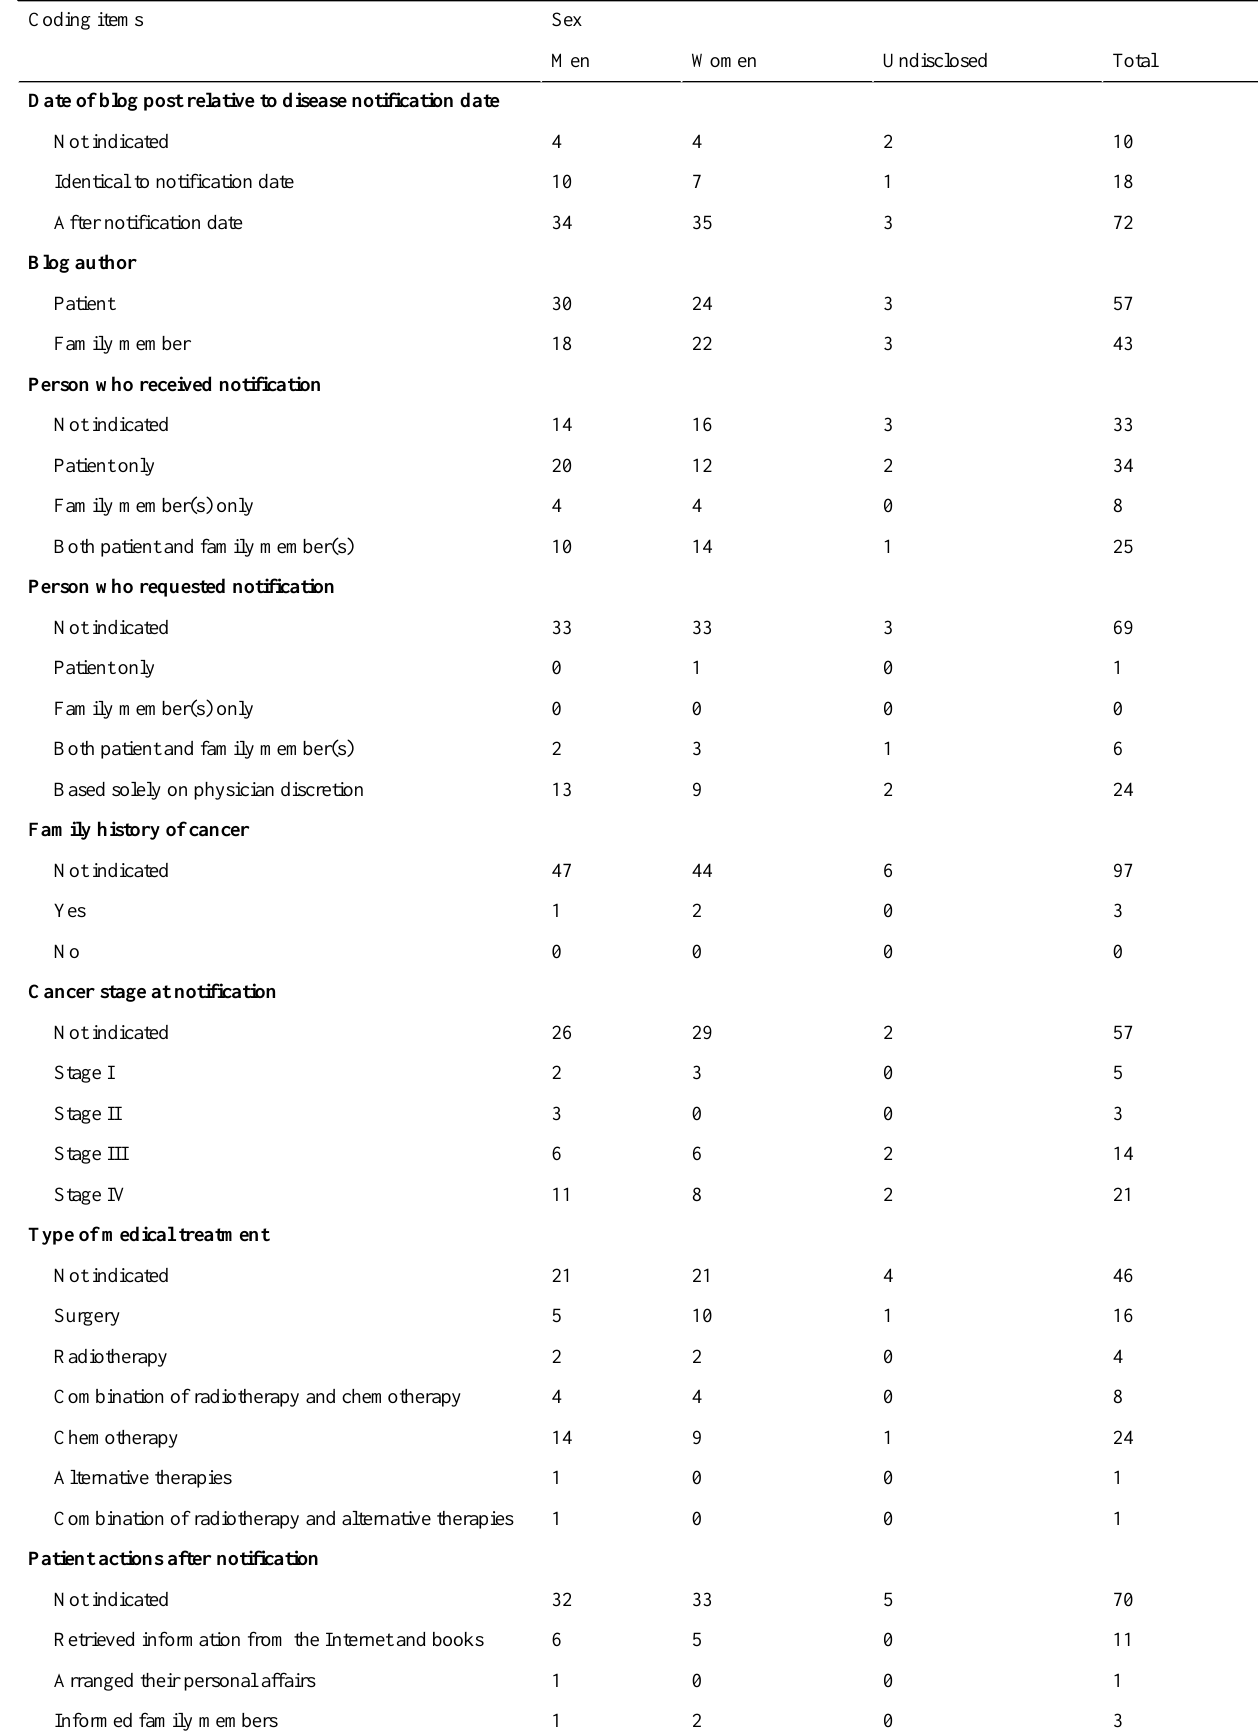
Table 1. Results of coding of the blog content (n=100